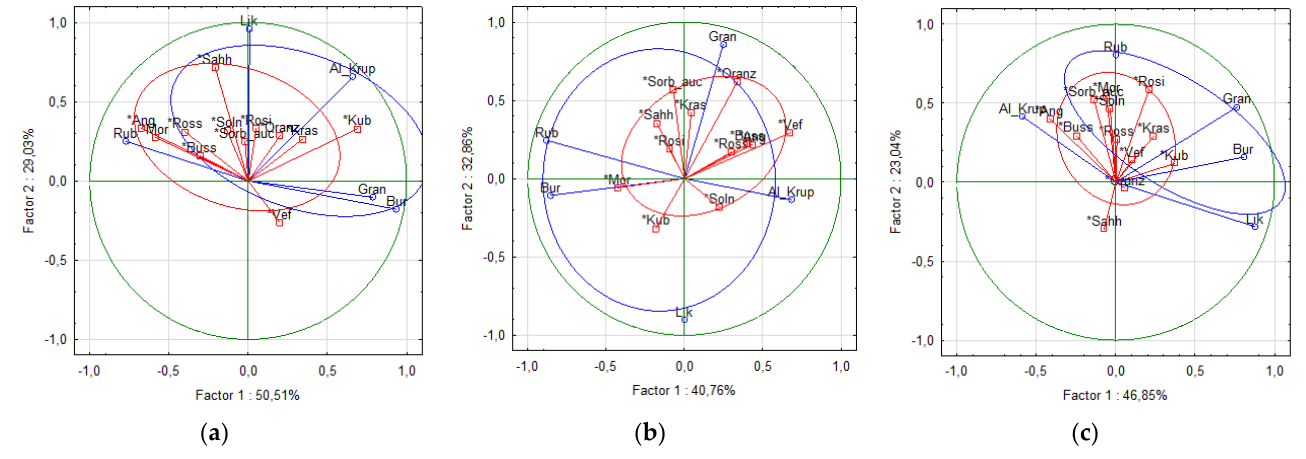
Figure 4. PCA score plots of different Sorbus fruit ( a ), juice ( b ), and pomace ( c ) samples.